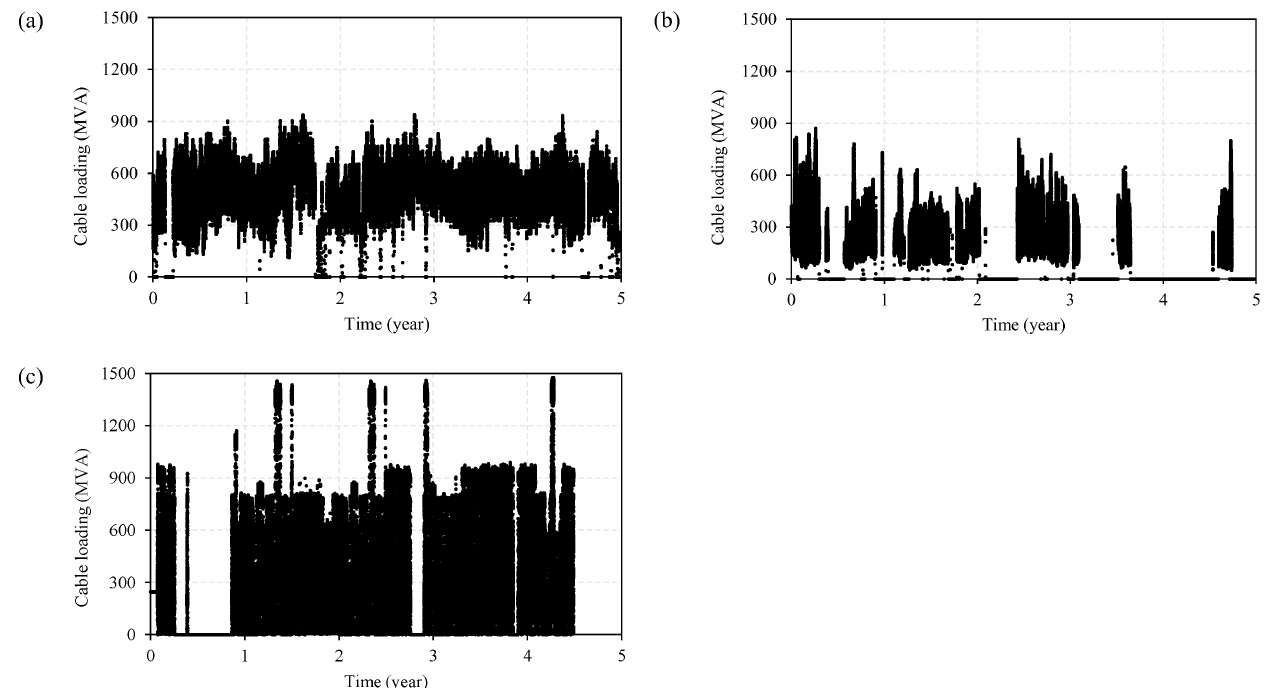
Figure 3. Loading data for ( a ) BRU cables ( b ) LT cables ( c ) DP cables.